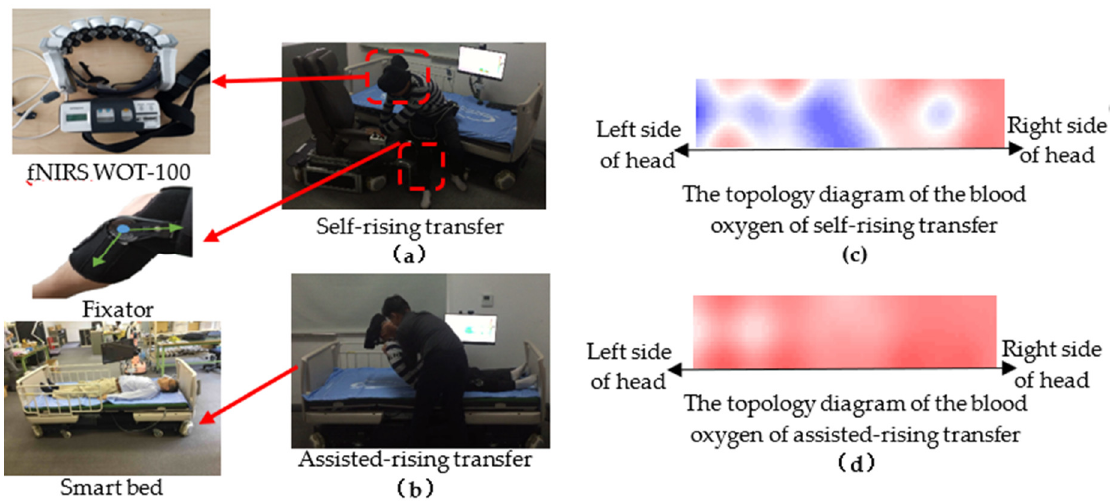
Figure 2. Rising transfer based on the platform of multiple welfare-robots in smart house.